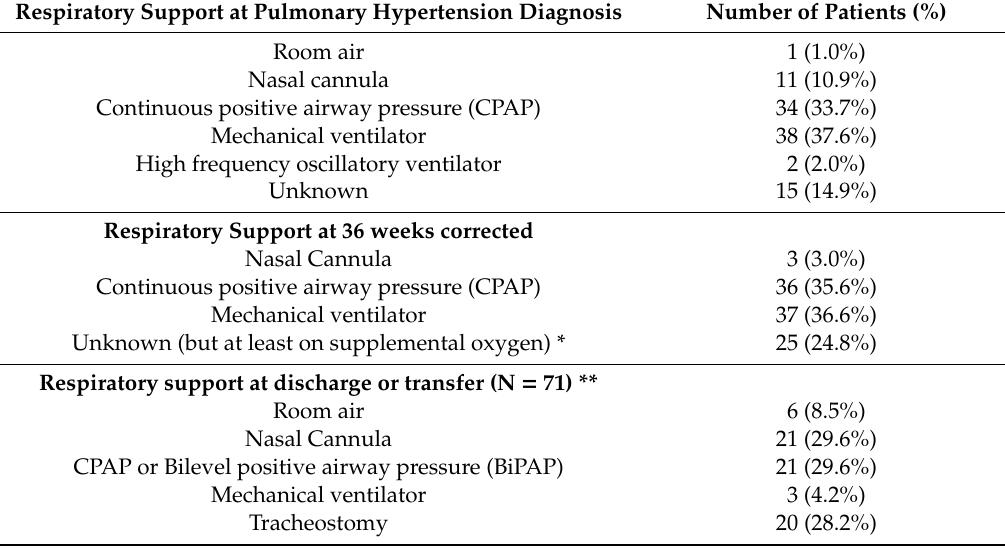
Table 3. Respiratory